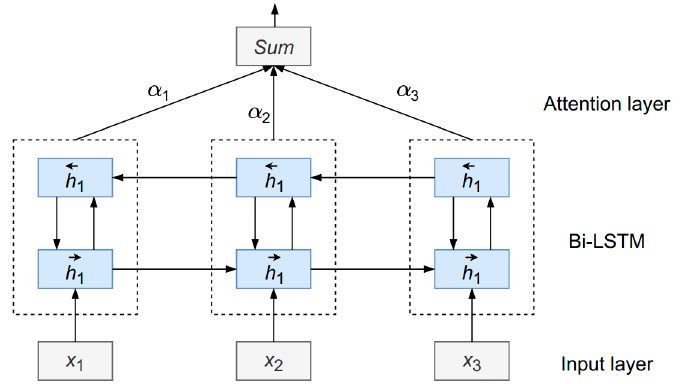
Figure 5. Architecture of the attention-based bi-directional LSTM.